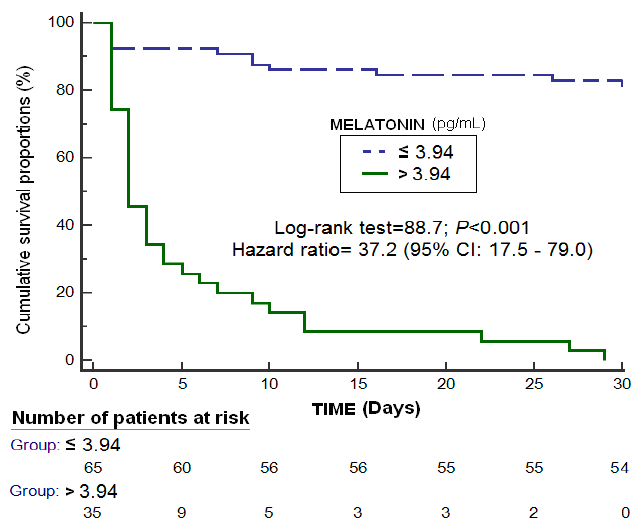
Figure 2. Survival curves at 30 days using serum melatonin levels >3.94 pg/mL as the cut-off.